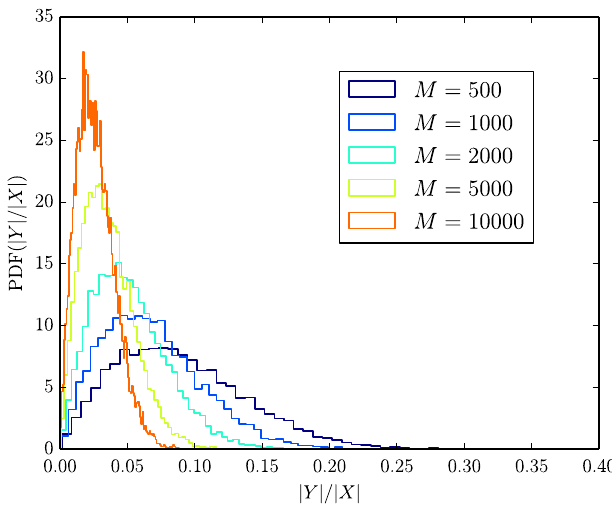
FIG. 21. The same as in Fig. 20 but with γ ¼ 1 . 2